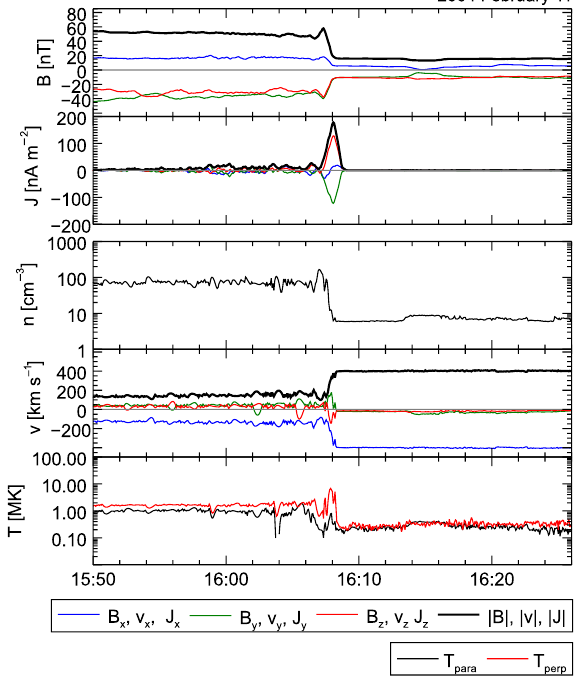
Figure 2. Example of a bow shock crossing during an outbound or- bit on 11 February 2004. The upper and middle panels show Cluster 1 magnetic field data and the curlometer results in GSE coordinates after application of a 30s averaging window. The lower panel shows Cluster 1 CIS hot ion density n , velocity v , and temperature T . At 16:08UT the transition from magnetosheath plasma (left-hand side) into undisturbed solar wind plasma (right-hand side) is visible within the particle data as well as within the magnetic field data. During the bow shock crossing a clear current density peak is seen.